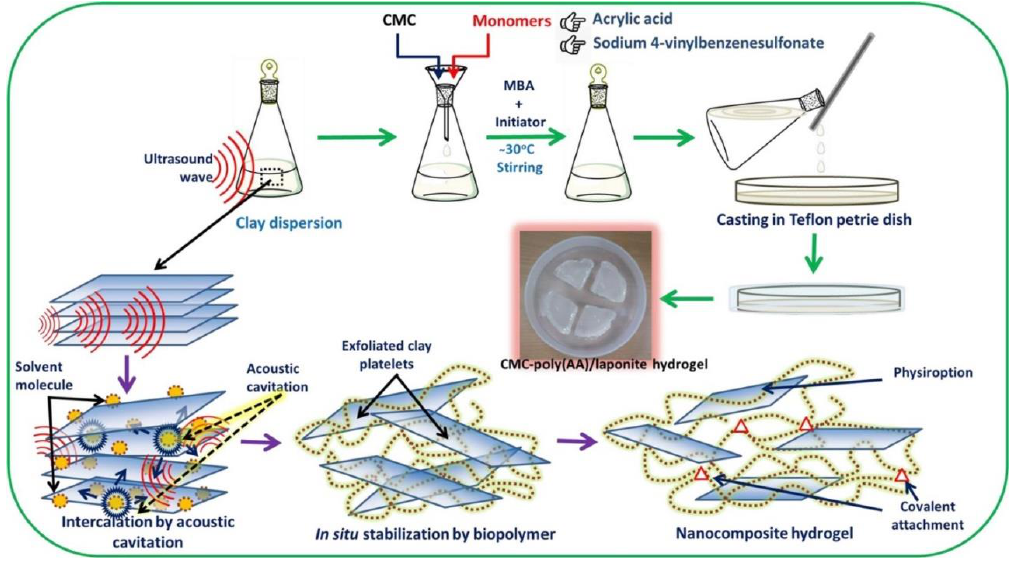
Figure 2. Synthesis of in situ laponite based semi-IPN composite hydrogel. Reproduced with the permission of [47] , Copyright 2020 Elsevier.